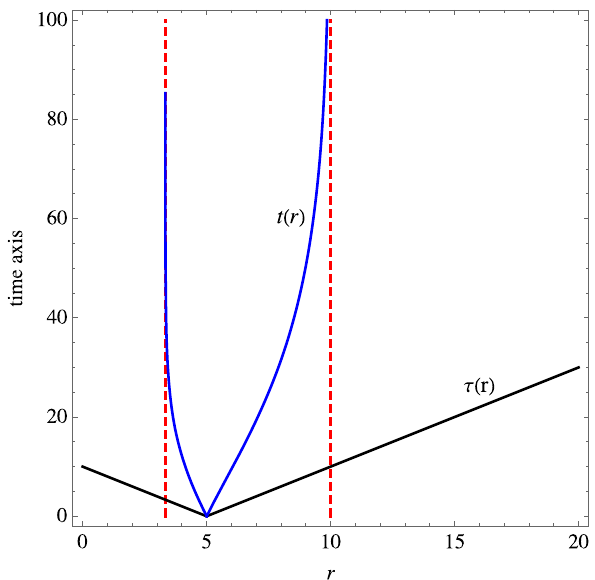
Fig. 2 The radial null geodesics plotted for γ = 0 . 06, E = 0 . 5 and r i = 5. The diagrams indicate the asymptotic behavior of t ( r ) (blue curves) and horizon crossing of τ( r ) (black lines)